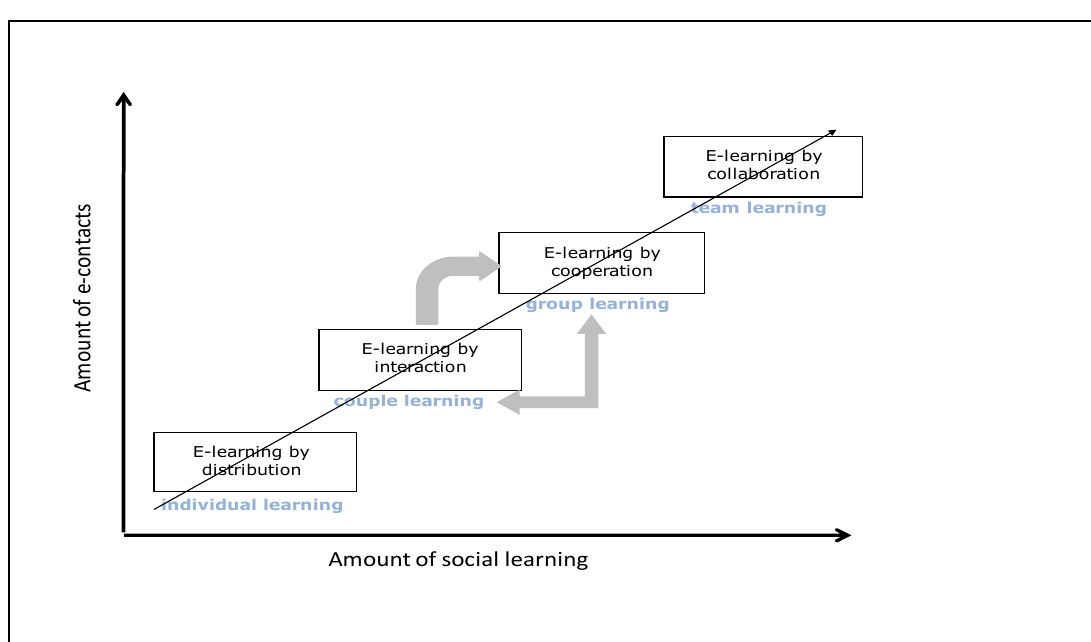
Figure 1 . Knowledge construction by increasing social learning. Adapted from Albrecht and Tillmann